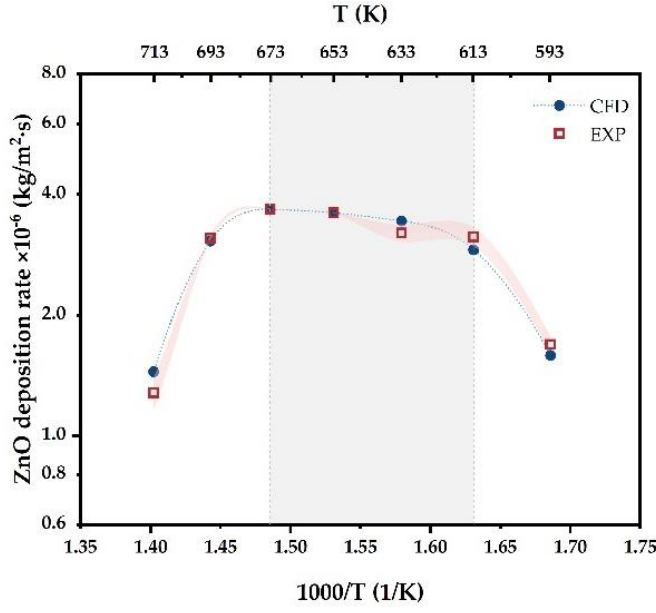
Figure 3. ZnO deposition rate as a function of temperature ranging from 593 to 713 K.